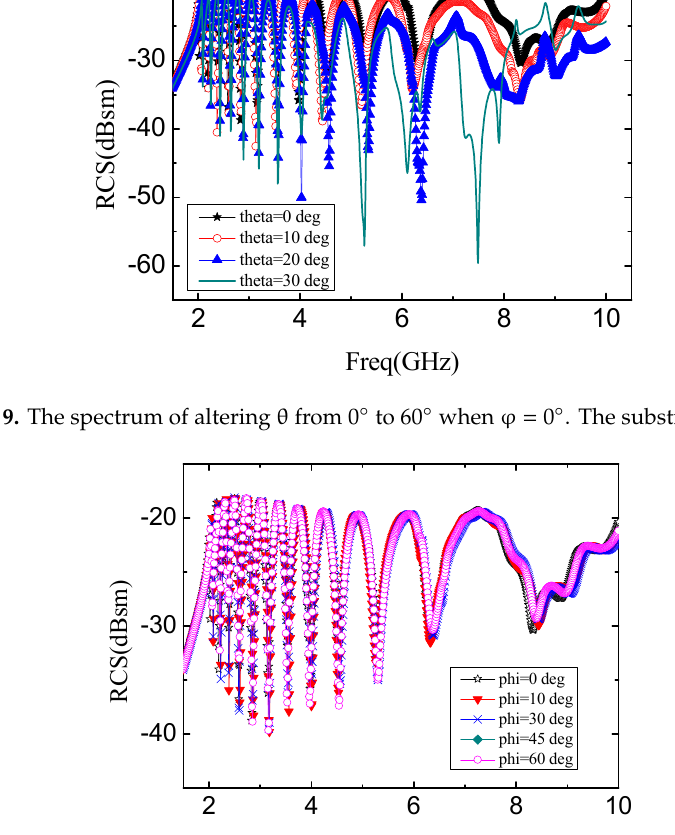
Figure 10. The spectra corresponding to ϕ from 0 ◦ to 60 ◦ when θ = 20 ◦ . The substrate is F4BM.